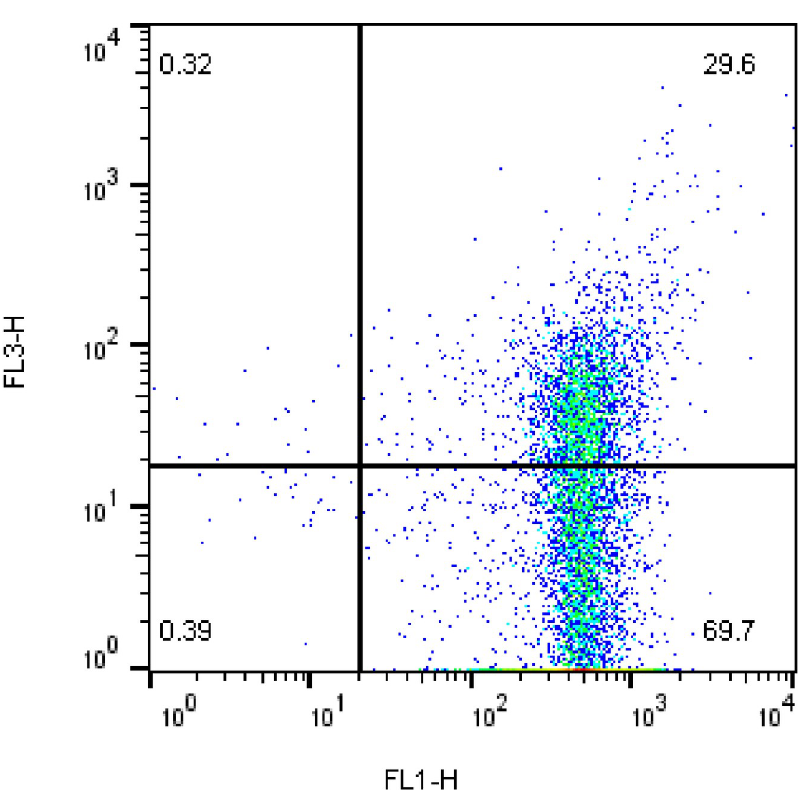
Fig 2. Flow cytometric detection of rooster sperm stained with Rhodamine123 (FL1-H) and PI (FL3-H) after freeze-thaw process. R123+PI- quadrant contains spermatozoa with active mitochondria; R123+ PI+ quadrant contains dead spermatozoa.